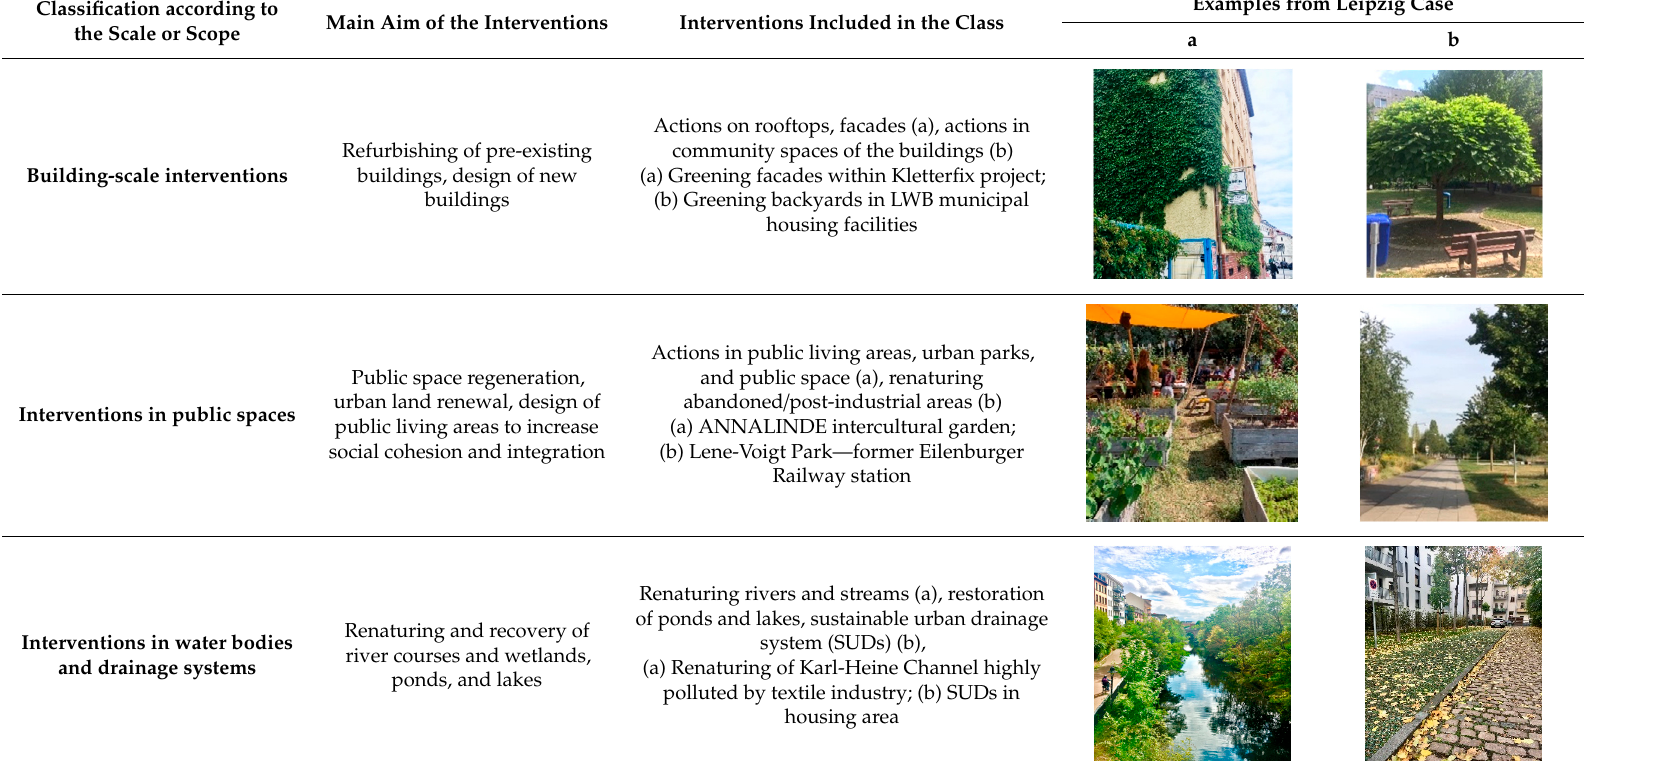
Table 1. Classification of NBS interventions and selected cases from Leipzig referred to each category (based on [23 – 25], with own additions). Photos: D. Dushkova. Classification according